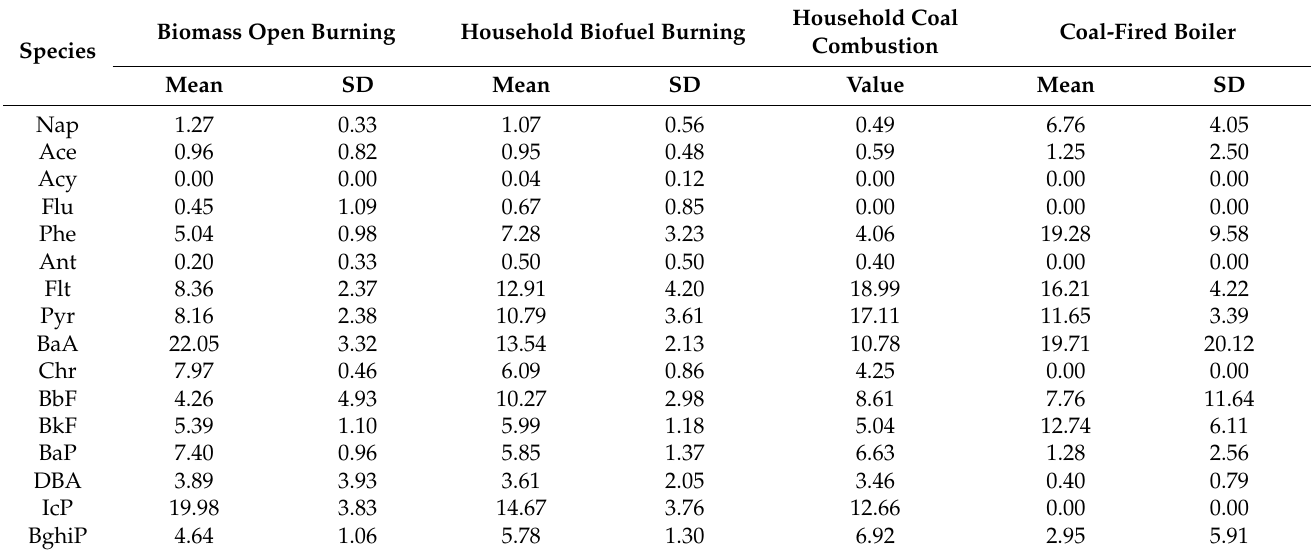
Household Coal Coal-Fired Combustion